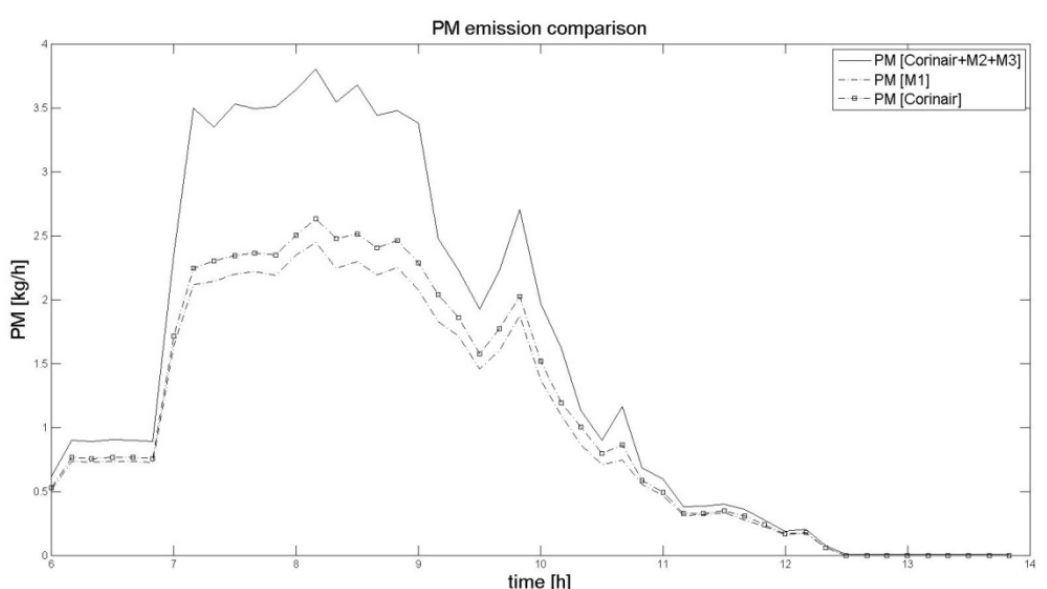
Figure 10. PM10 distribution with the three methods.